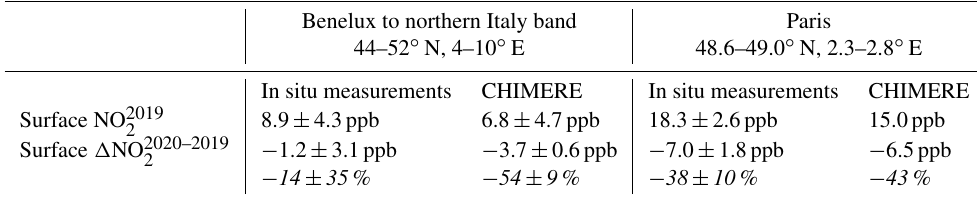
Table 6. Comparison of nitrogen dioxide concentrations in the period 1–15 April 2019 and the changes between this period in 2020 with respect to 2019, for two target regions in Europe (rectangles in Fig. 3a), derived from surface in situ measurements and model simulations. Values after ± indicate 1 standard deviation and italics show percentage changes. Due to lack of representativity, model standard deviation within the Paris sector is not